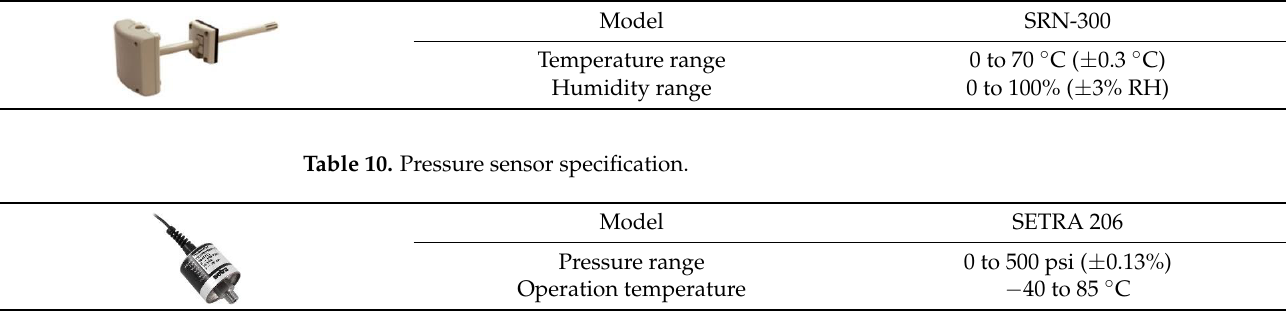
Table 9. Temperature and humidity sensor specification.